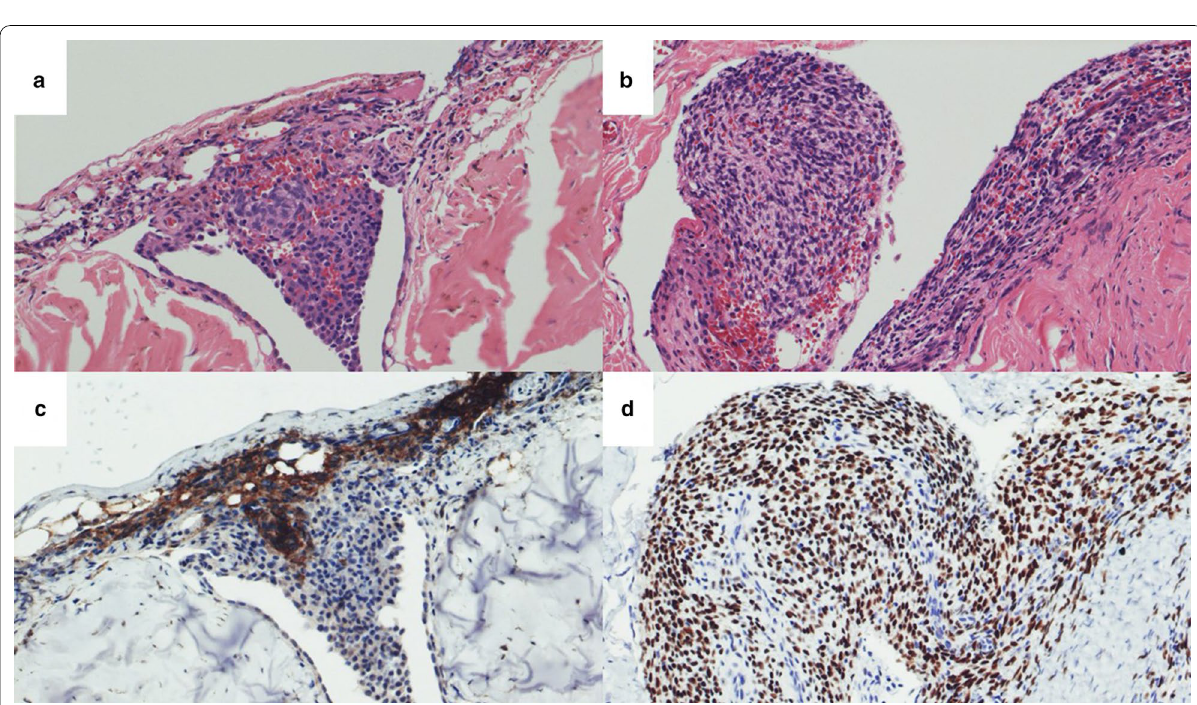
Fig. 3 Pathological specimens from both cases showing ectopic endometrial lesions on the surface of the diaphragm, accompanied by inflammatory granulation with hemosiderin-laden macrophages ( a : Case 1/ b : Case 2). Immunohistochemical staining of CD10 ( c : Case 1) and estrogen receptors ( d : Case 2) with a positive expression that confirms the histological nature of